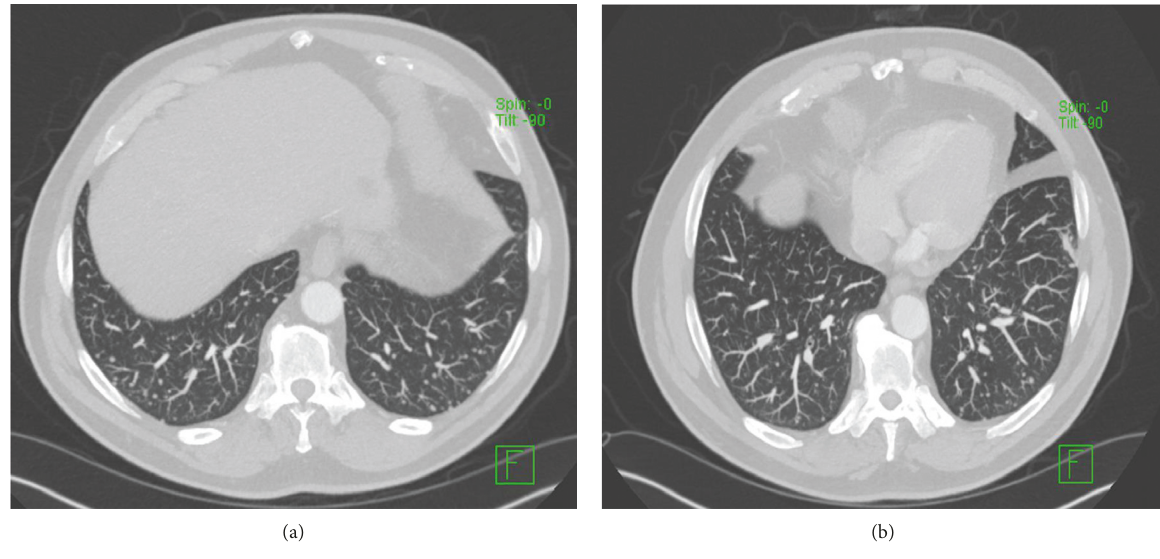
Figure 2: Chest CT showing numerous small lung